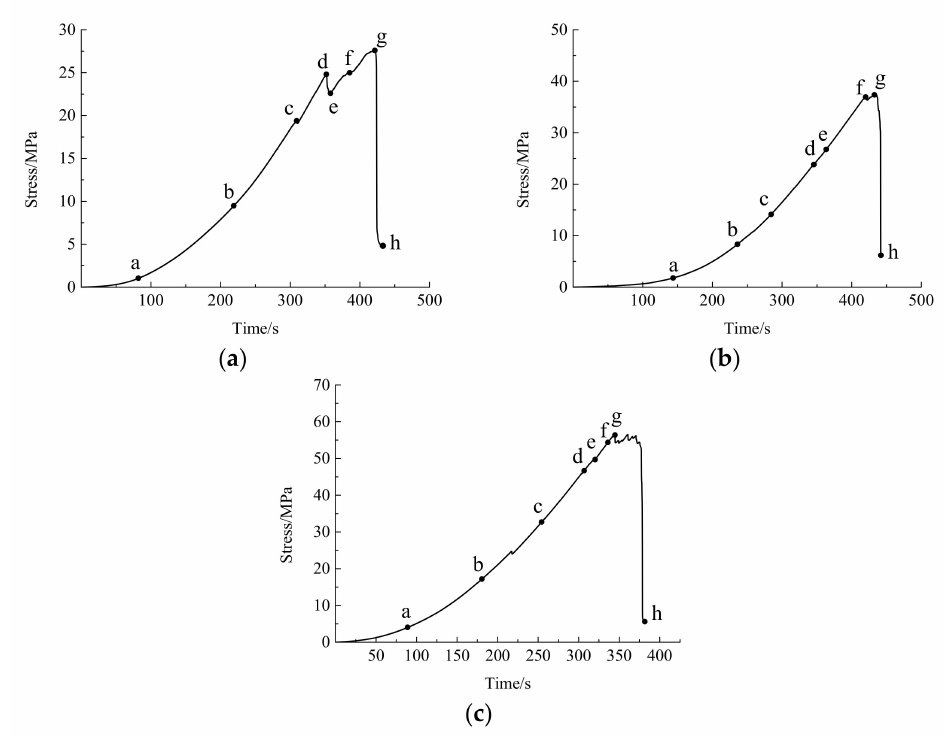
Figure 6. Stress–time curves for each specimen. ( a ) P − 30 − 1; ( b ) P − 60 − 2; ( c ) P − 90 − 1. In unstable fracture stage 1, the downward strain concentration area appears at the right end of crack 2 (cid:13) , where the maximum strain value is 0.021, indicating that tensile crack 4T that is developing downward appears at the right end of crack 2 (cid:13) . In unstable fracture stage 2, wing crack 3T and tensile crack 4T continue to develop upward and downward in the direction of maximum compressive stress, while tensile crack 5T appears on the left side of tensile crack 4T. As tensile crack 5T appears suddenly and has a certain width, there is no obvious strain concentration area in the principal strain nephogram, but a small failure area is formed. In the unstable fracture stage 3, tensile crack 5T rapidly expands to the right end of crack 2 (cid:13) and the bottom of the specimen, and finally becomes a tensile-shear composite crack, denoted as 5T-S. Meanwhile, a strain concentration area appears between the left end of crack 2 (cid:13) and the left end of crack 3 (cid:13) , where the maximum strain value reaches 0.026, indicating the presence of tensile crack 6T here. There is also a strain concentration area at the left end of crack 1 (cid:13) with a maximum strain of 0.023, where the inclined secondary crack 7S is generated. At the peak stage, the strain concentration area at the left end of crack 1 (cid:13) is connected to the left end of crack 2 (cid:13) . At this time, the maximum strain value reaches 0.044, representing that the inclined secondary crack 7S develops toward the left end of crack 2 (cid:13) and finally connects with it. This 7S crack also transforms from a shear crack to a tensile-shear composite crack, denoted as 7T-S. At the post-peak failure stage, the limestone specimens suffer damage very quickly, and a large number of damage